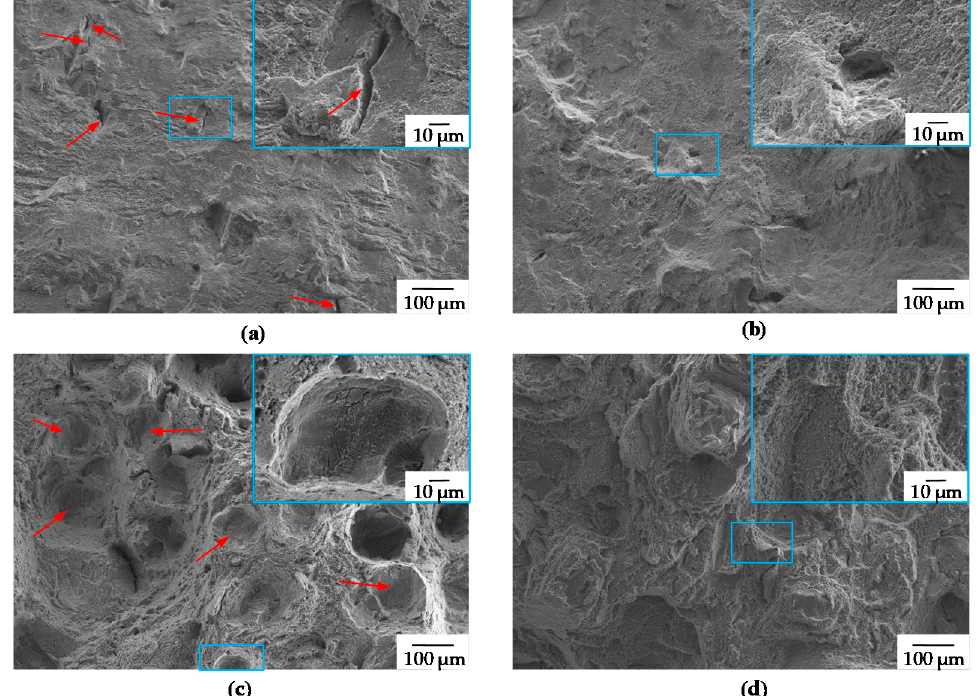
Figure 16. Fracture surfaces ( a ) horizontal as built, red arrows indicating cracks from insufficient binding ( b ) horizontal T4 smooth surface, typical ductile fracture surface ( c ) vertical as built, red arrows indicating “craters” corresponding to Figure 1a ( d ) vertical T4, typical ductile fracture surface. (EHT = 15 keV, WD = 13 mm, Mag = 100×/1.000×).